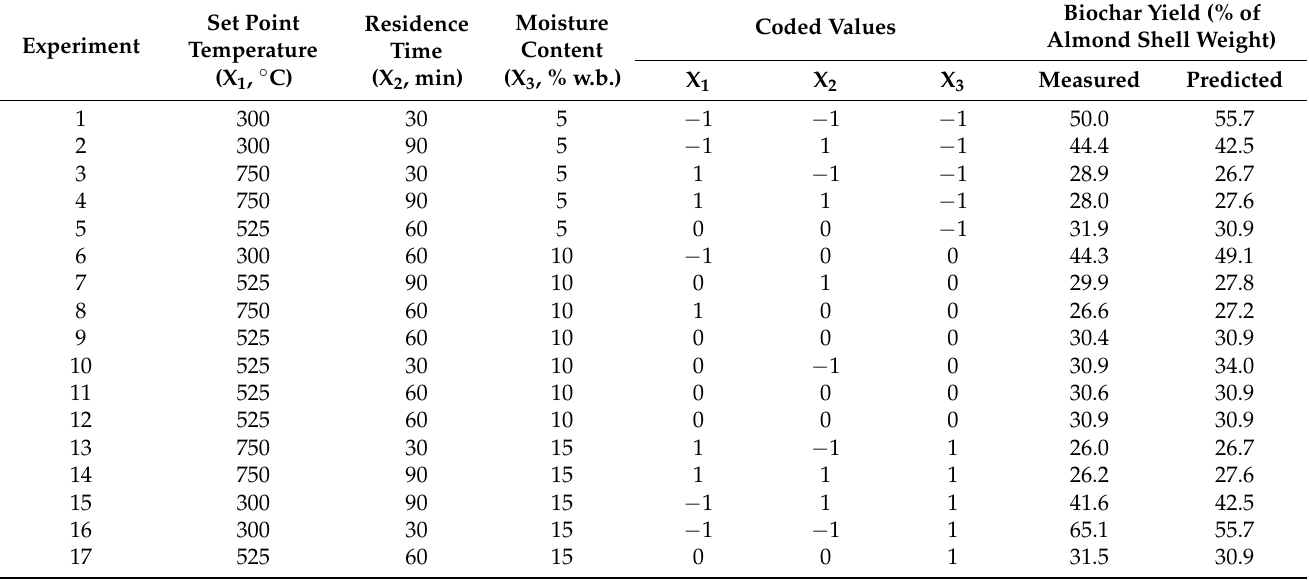
Table 2. Real and coded values of the studied parameters and the measured and predicted biochar